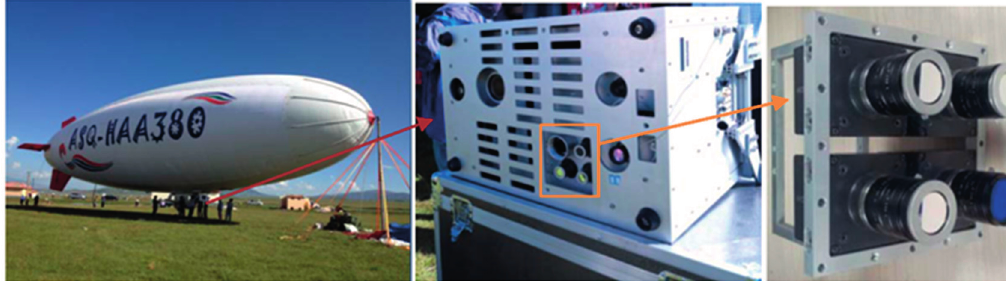
Figure 10. Experimental scene and equipment